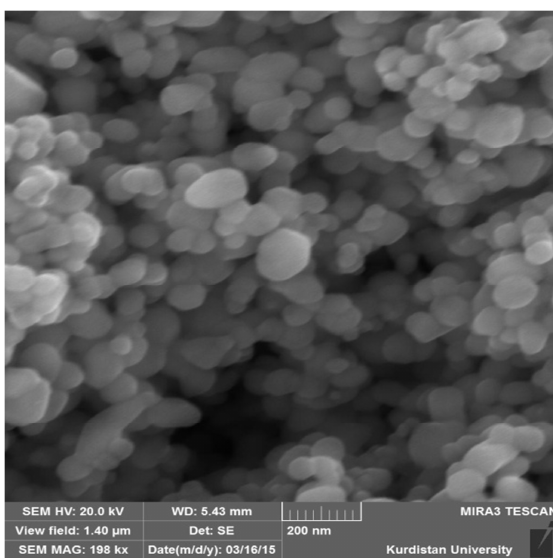
Figure 2. Scanning electron microscopy (SEM)